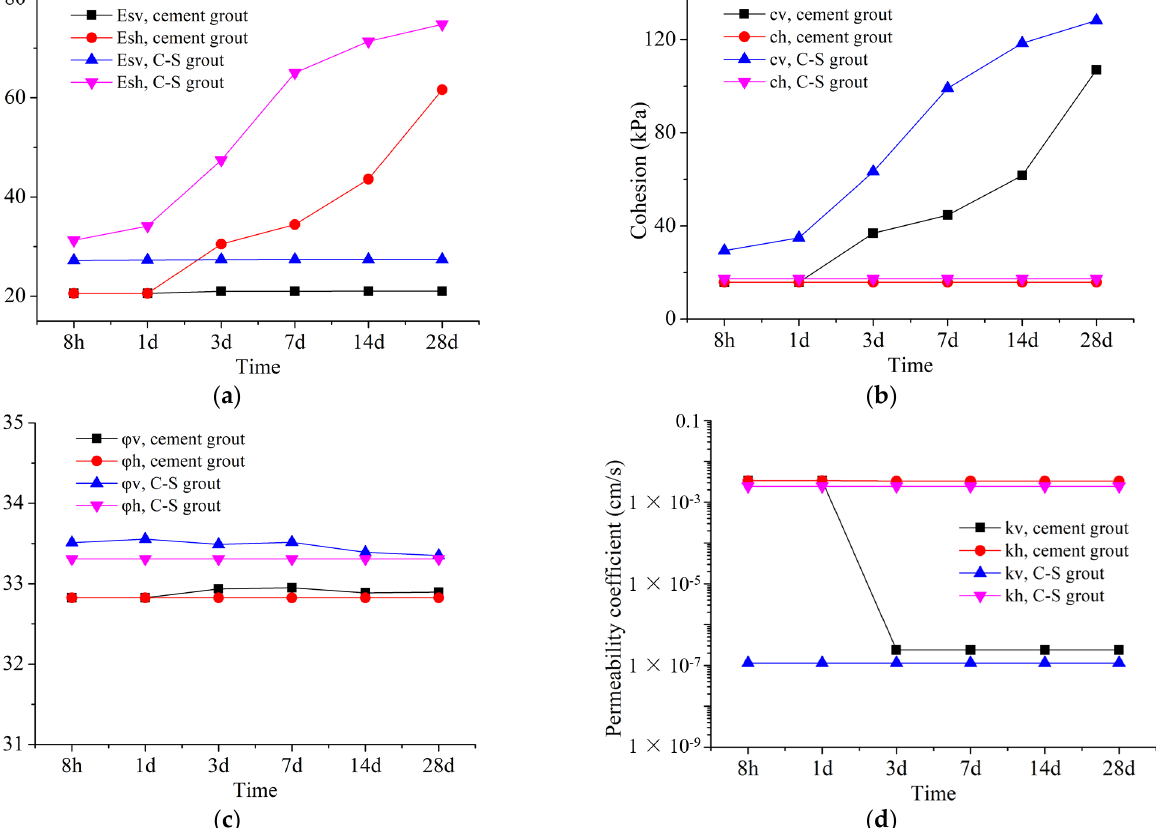
Figure 15. Comparison on reinforcement effects of two grouts. ( a ) Modulus of compression. ( b ) Cohesion. ( c ) Internal friction angle. ( d ) Permeability coefficient.